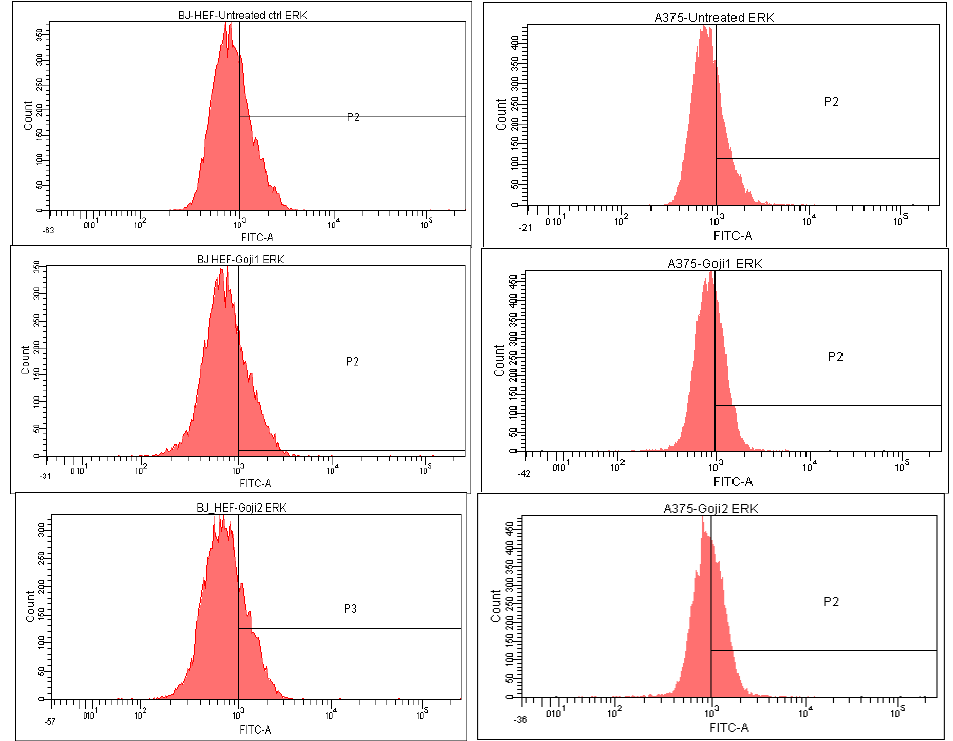
Figure 8. The extracellular signal-regulated kinase ERK 1/2 modulation in normal BJ fibroblasts ( left ) and A375 malignant melanoma ( right ) following the 24-h exposure to zeaxanthin 1 and 2 .